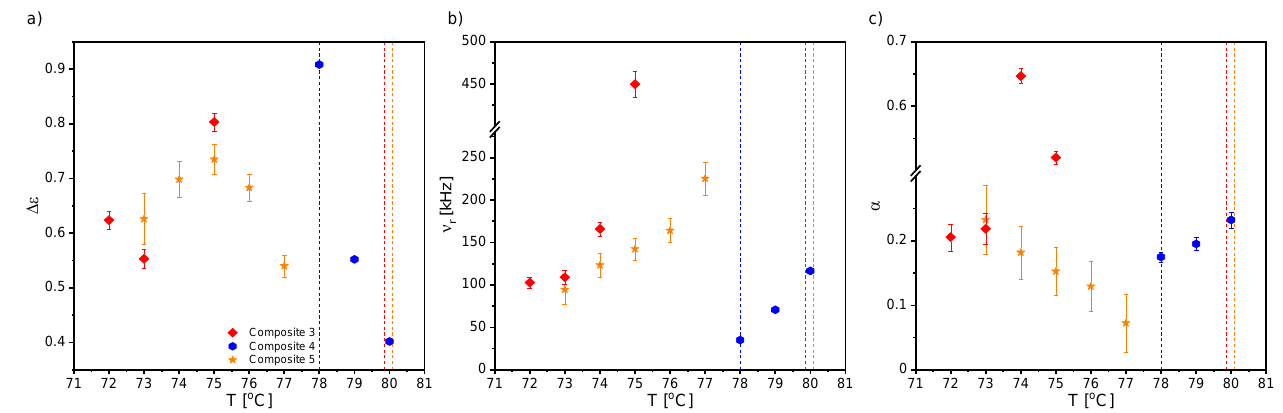
Figure 8. Temperature dependence of the dielectric increment, ∆ ε ( a ); the relaxation frequency, ν r ( b ); and the α distribution parameter of the relaxation time ( c ) of the SM for Composites 3–5. The legend in graph ( a ) is the same for all graphs. The vertical dashed lines represent the N*–TGBA*–SmA* phase transition temperature (during cooling), respectively.